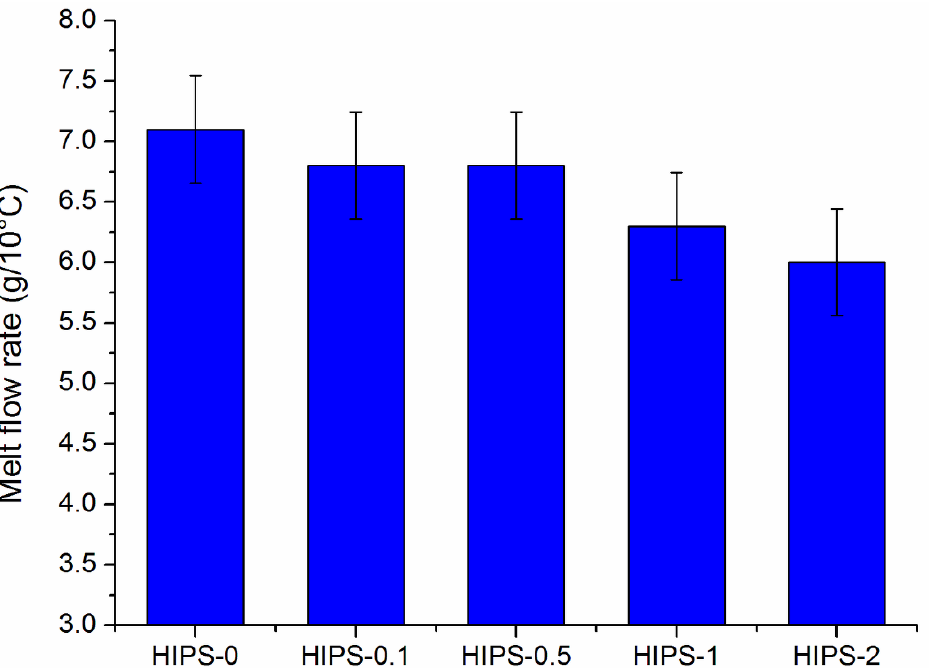
Figure 6. Melt flow rate (MFR) of the pure HIPS filament and the HIPS/rGO composite filaments.